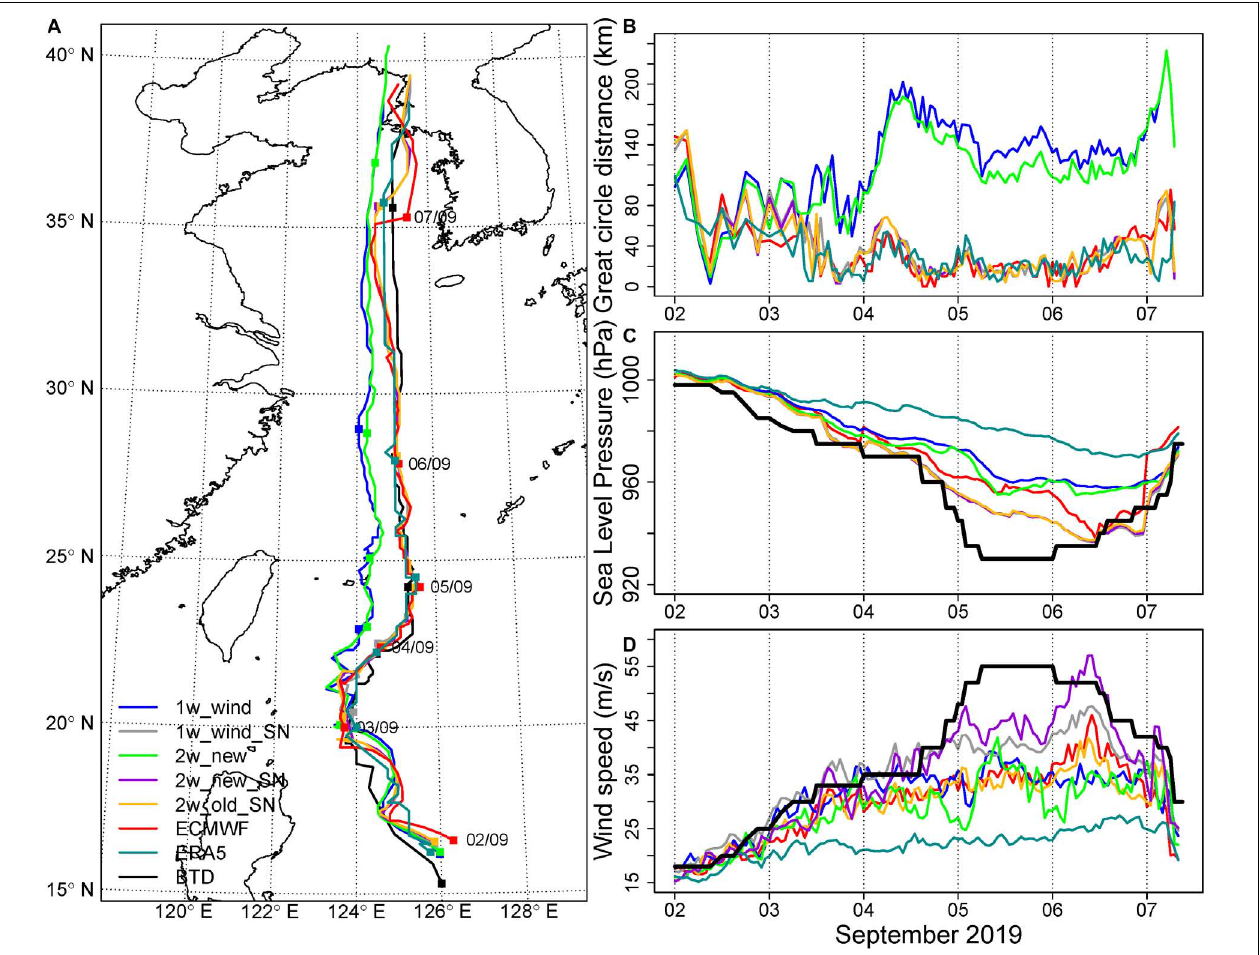
FIGURE 3 | (A) Tracks of Typhoon Lingling from model results and best track data (BTD) from the China Meteorological Agency; time series of (B) great circle distances between modeled and observed tracks, (C) the minimum mean sea level pressure and (D) the maximum 10 m wind